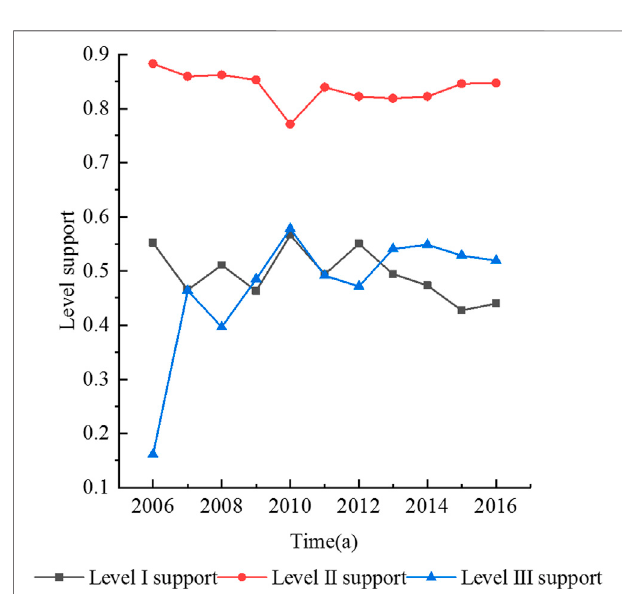
FIGURE 10 | Evolution curve of each grade ’ s support degree under human in fl uence.